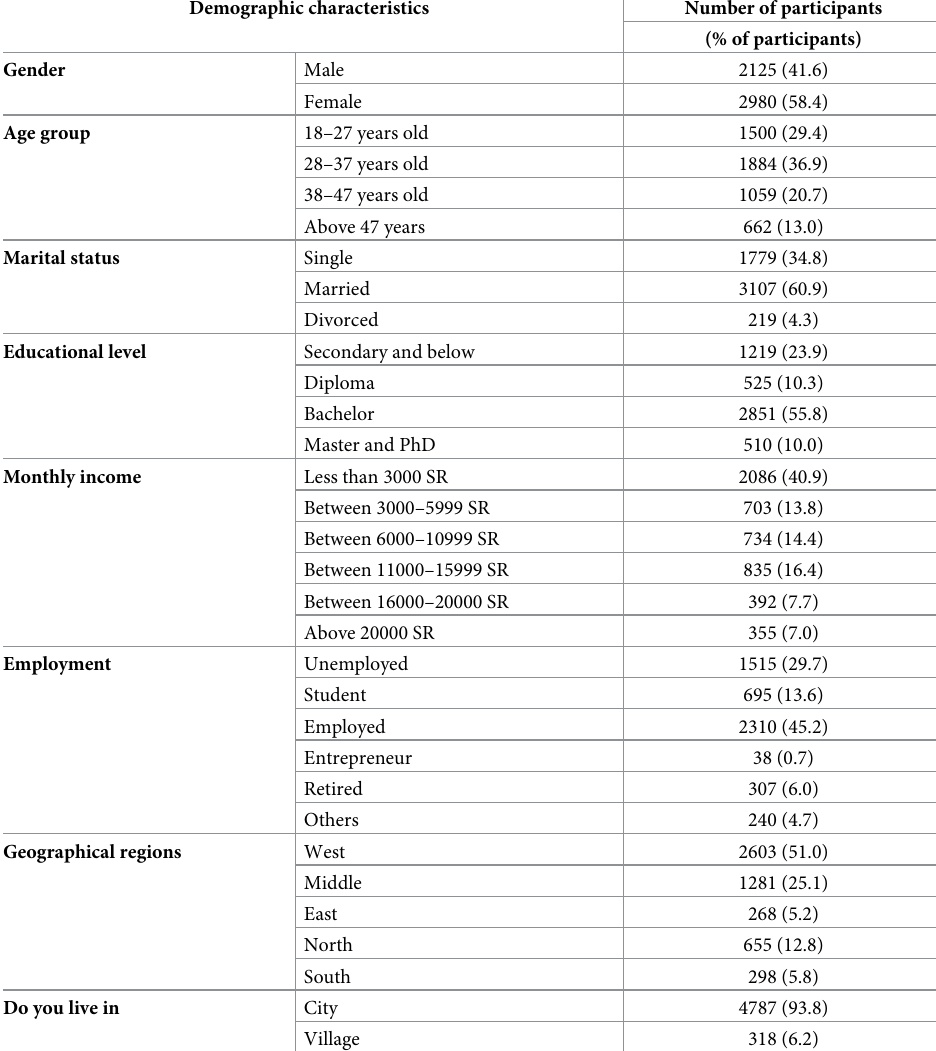
Table 2. Sociodemographic characteristics of the